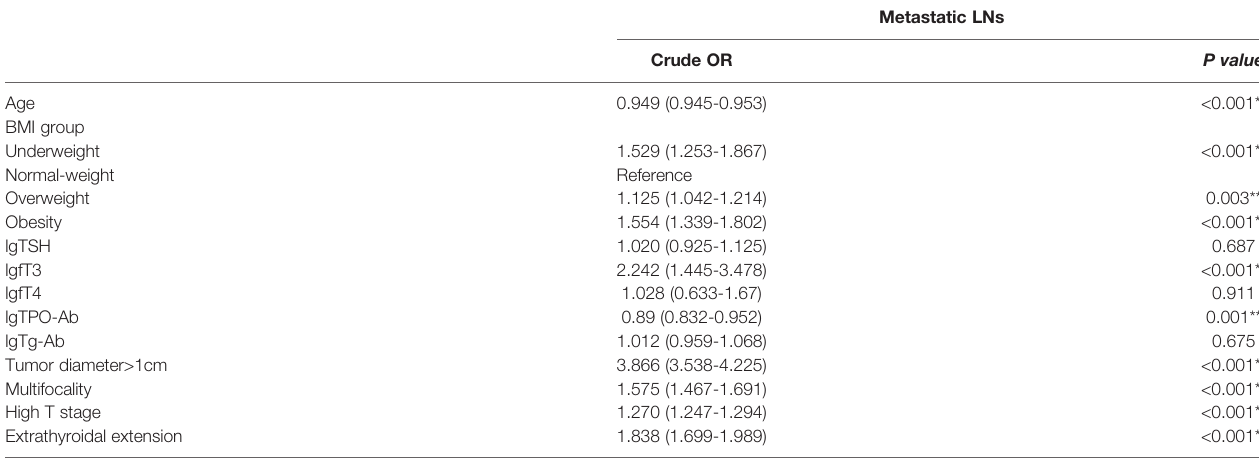
TABLE 2 | Regression analysis of in fl uencing factors of metastatic LNs.